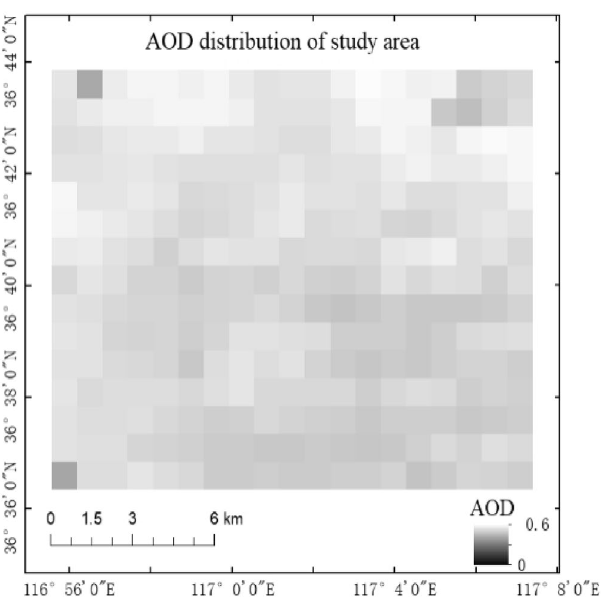
Figure 3. AOD distribution in the study area. AOD reflects the air quality. Generally, the brighter in image is, the higher the AOD value is, and the more serious the air pollution is. Map created in ArcMap 10.5 of the Environmental System Resource Institute, Inc. (https:// www. esri. com/ softw are/ arcgis/ arcgis- for- deskt